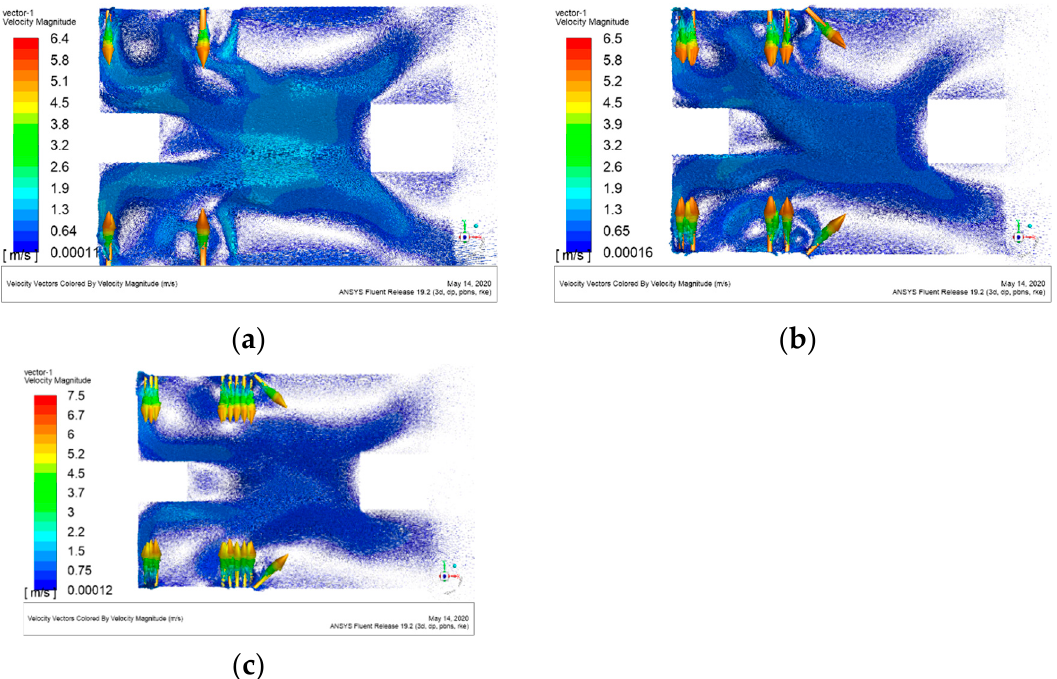
Figure 4. Velocity vector diagrams of the flow field in the beam expanding system: ( a ) velocity vector diagram for plan A; ( b ) velocity vector diagram for plan B; ( c ) velocity vector diagram for plan C.